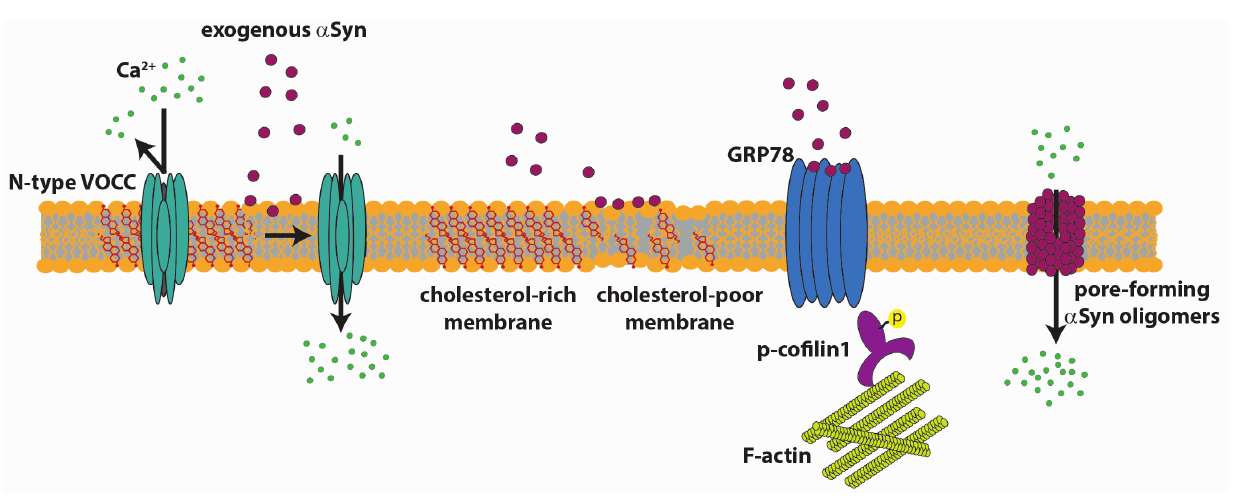
Figure 3. Targets of extracellular (cid:2)Syn. Extracellular soluble (cid:2)Syn induces an increase in calcium entry by acting on the fluidity of the membrane or by activating N-type calcium channels that shift to cholesterol-poor domains of the membrane. Extracellular soluble (cid:2)Syn clusters GRP78 at the plasma membrane, with ensuing activation of a pathway that leads to cofilin 1